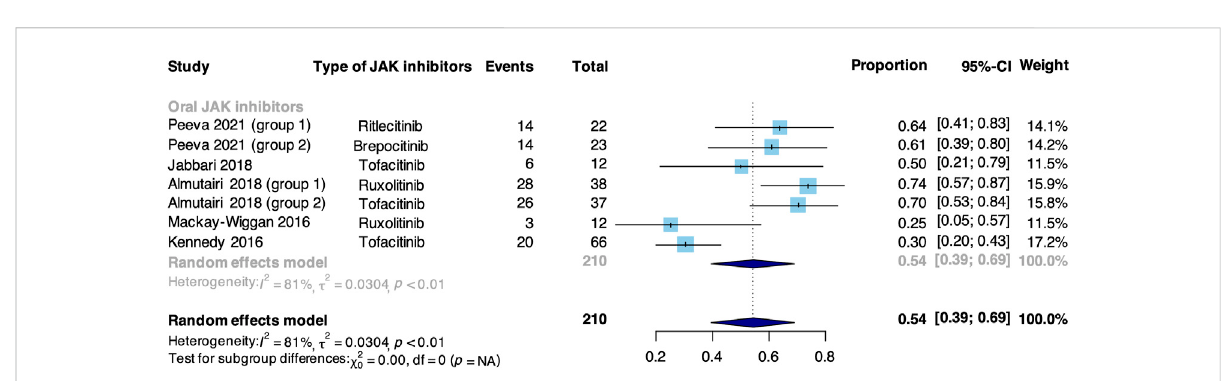
FIGURE 5 Forest plot of recurrence rate in patients treated with JAK inhibitors based on